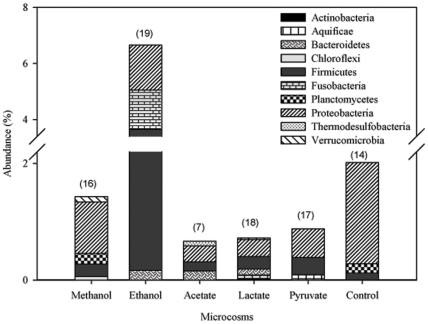
The abundances of the unique genera detected in bacterial phyla in the defined microcosm.The number of the unique genera detected was presented above the bars in parentheses.